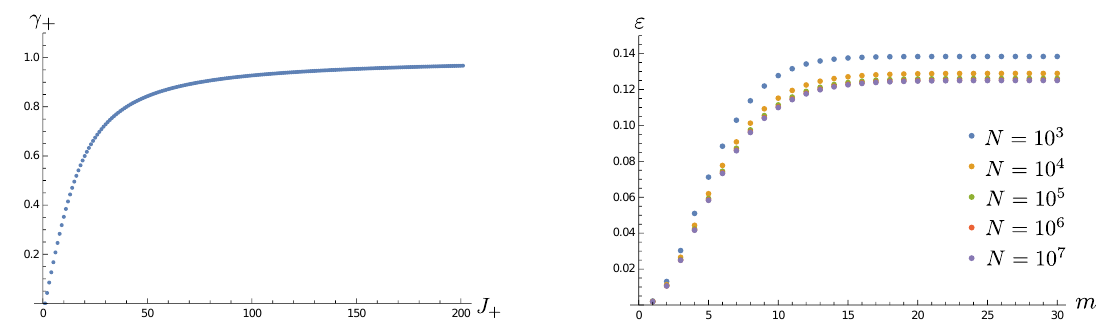
Figure 5 . Left: (cid:13) + ( J + ) for N = 1000. Right: " ( m ) at large N